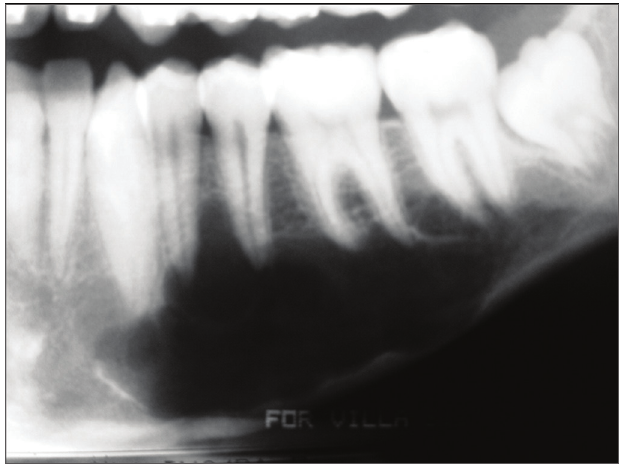
Figura 3. Cisto ósseo traumático no corpo mandibular esquerdo com padrão multilocular, dando à lesão uma aparência tumoral. Há preservação da placa cortical.